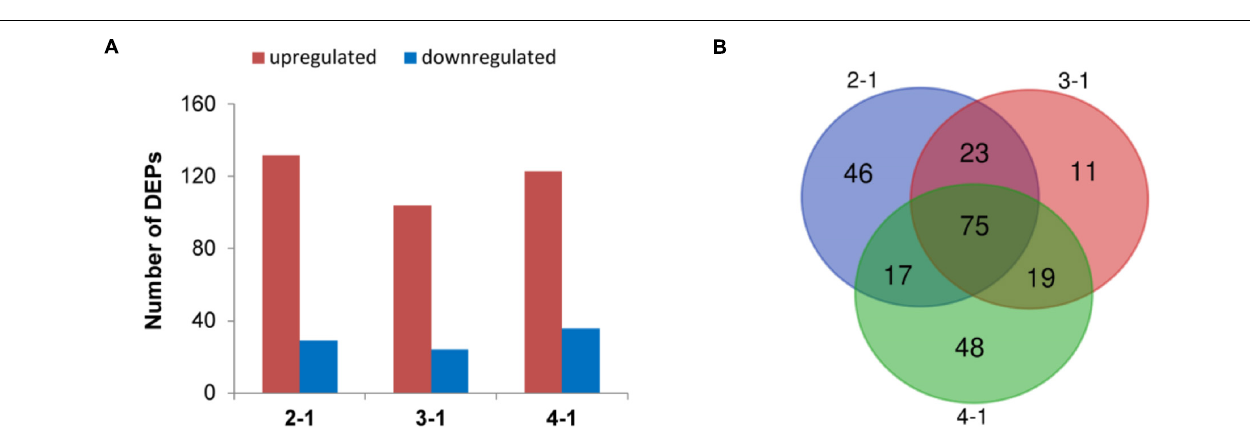
FIGURE 2 | Differentially expressed proteins (DEPs) involved in brown film formation in Lentinula edodes . (A) Numbers of DEPs that increased (red) and decreased (blue) in accumulation. Comparisons: 2-1, 45 days vs. 30 days; 3-1, 60 days vs. 30 days; and 4-1, 75 days vs. 30 days. (B) Venn diagram of DEPs in the three experimental